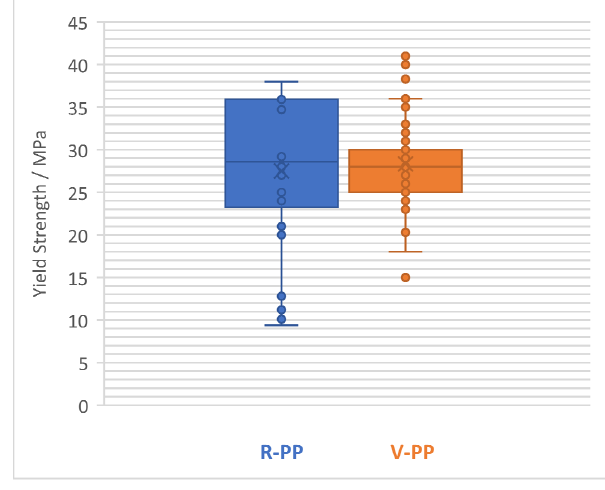
Figure 3. Yield strength of R-PP and V-PP; for data, see Table S2.